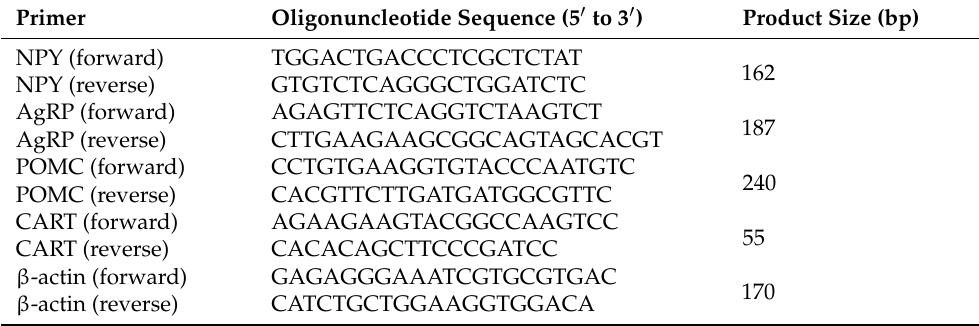
Table 2. Gene-specific primers used for real-time